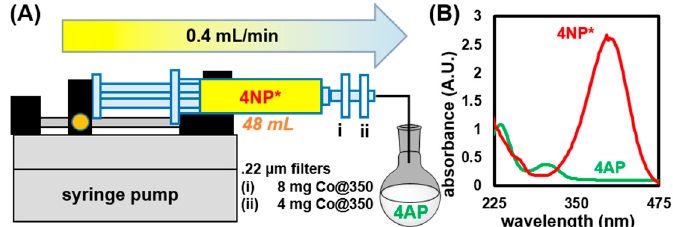
Figure 8. ( A ) Schematic illustration of a model flow reactor for reduction of 4NP* to 4AP. ( B ) UV-Vis spectrum of 4NP* and the resulting 4AP collected after passage through filters loaded with Co@350.